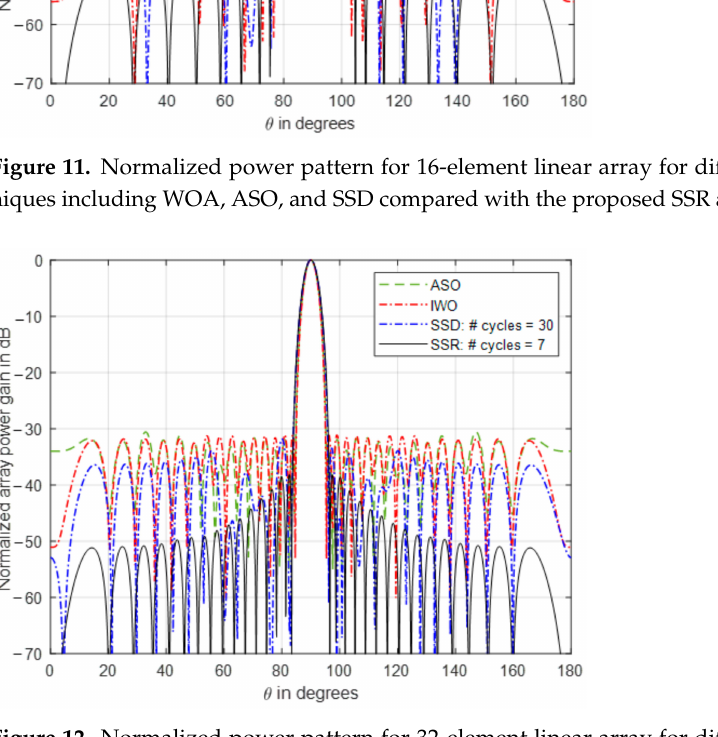
Figure 12. Normalized power pattern for 32-element linear array for different optimization tech- niques including ASO, IWO, and SSD compared with the proposed SSR